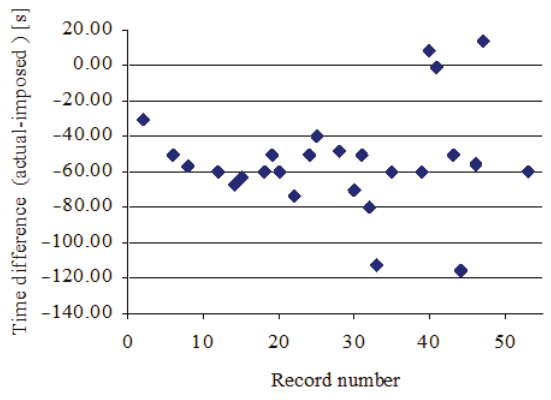
Figure 12. Diff erence between imposed and actual time